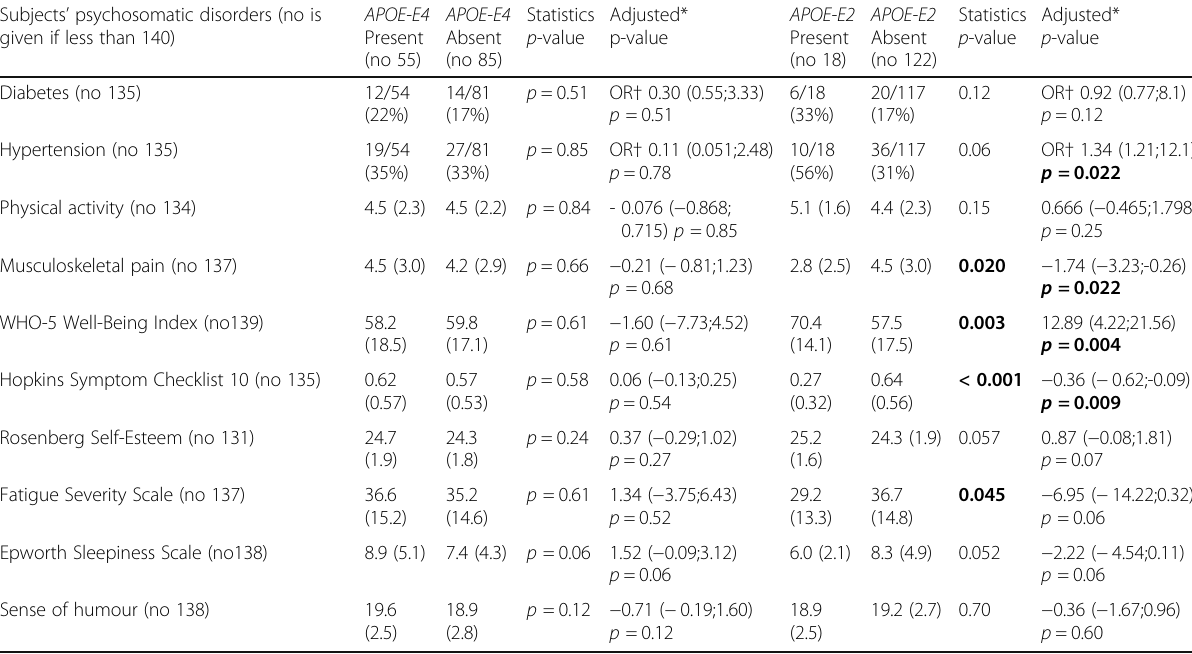
Table 2 Associations between comorbidity and APOE E4 and E2 variants Subjects ’ psychosomatic disorders (no is given if less than